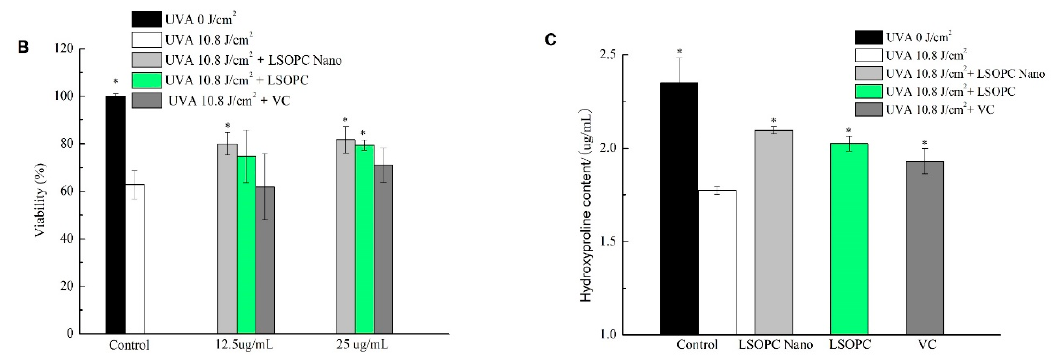
Figure 6. Cell viability of HFF-1 after di ff erent doses of UVA irradiation ( A ); protective e ff ects of Vc, LSOPC, and LSOPC Nano on HFF-1 cell after 10.8 J / cm 2 UVA irradiation ( B ); hydroxyproline formation before and after 10.8 J / cm 2 UVA irradiation with LSOPC, LSOPC Nano, and Vc (12.5 ug / mL), respectively ( C ). * p <